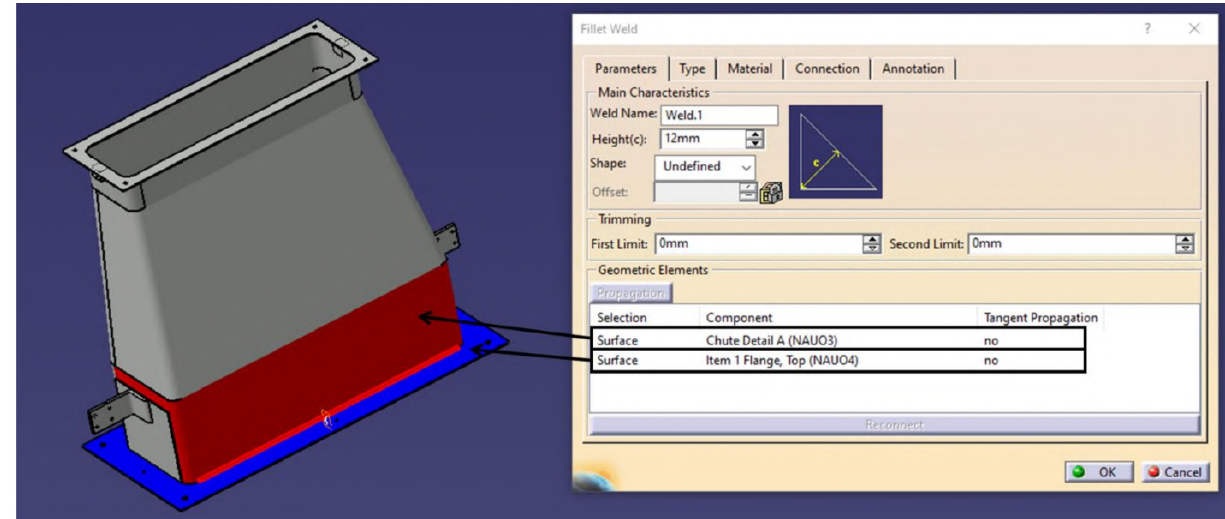
Figure 5. Computer-aided design (CAD) modeling of welded products with weld beads and product manufacturing infor-